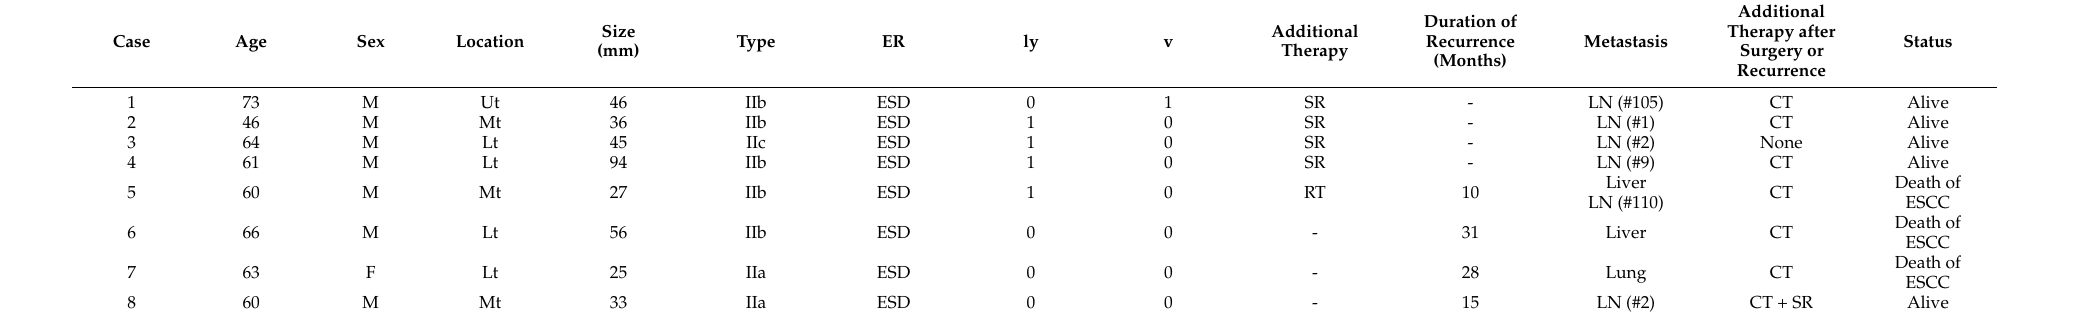
Table 5. Patients with recurrent metastatic disease after